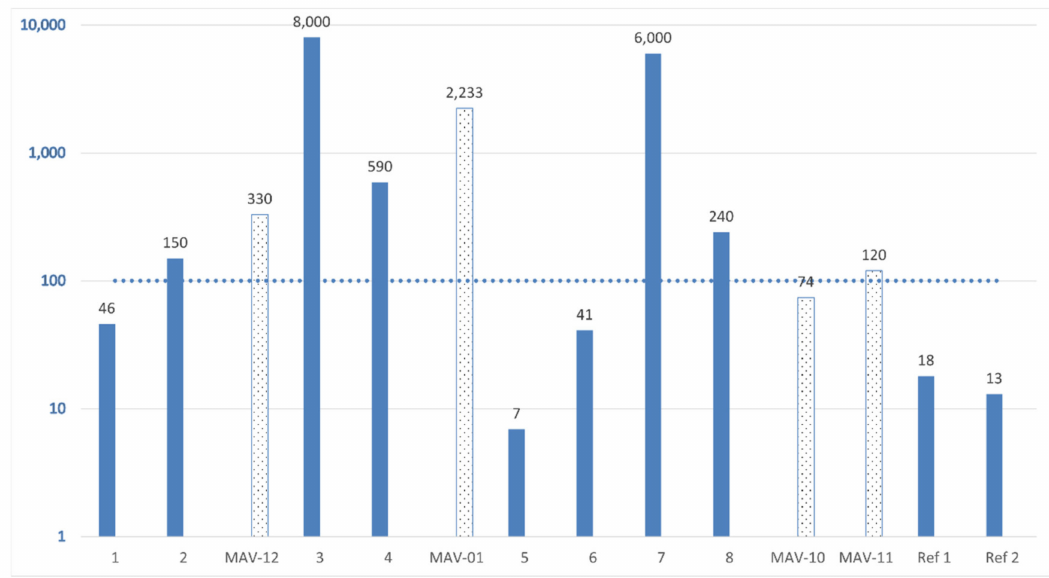
Figure 4. Log scale concentration (mg/kg) of lead (Pb) in surface soil sampled at 0–2 cm depth (solid blue bars) compared with Pb in soil sampled at 0.5 to 10 or 15 cm depth reported by EAGME [21]; (“MAV” values with dotted bars). See Figure 1 for location of sampling sites. The dotted line at 100 mg/kg indicates the quality criteria set for soil used in kindergartens, playgrounds, and schools in Norway [25]. Immediate action should be taken when the concentration of Pb in soil exceeds 700 mg/kg; however, immediate measures should be considered at 300 mg/kg. Abbreviations: MAV: